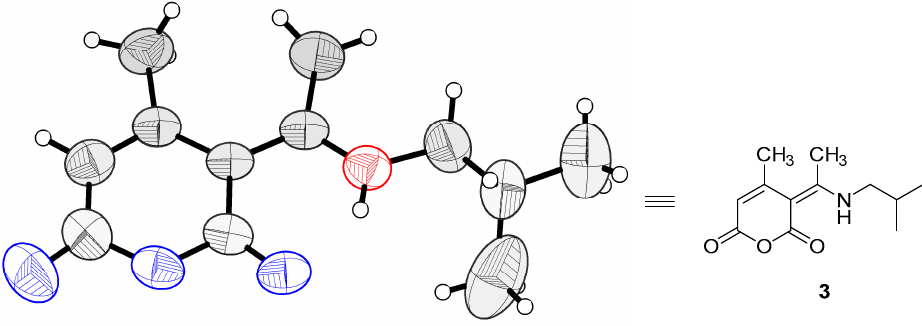
Figure 3. X-ray crystal structure of compound 3 . Table 1. Optimization of reaction conditions.